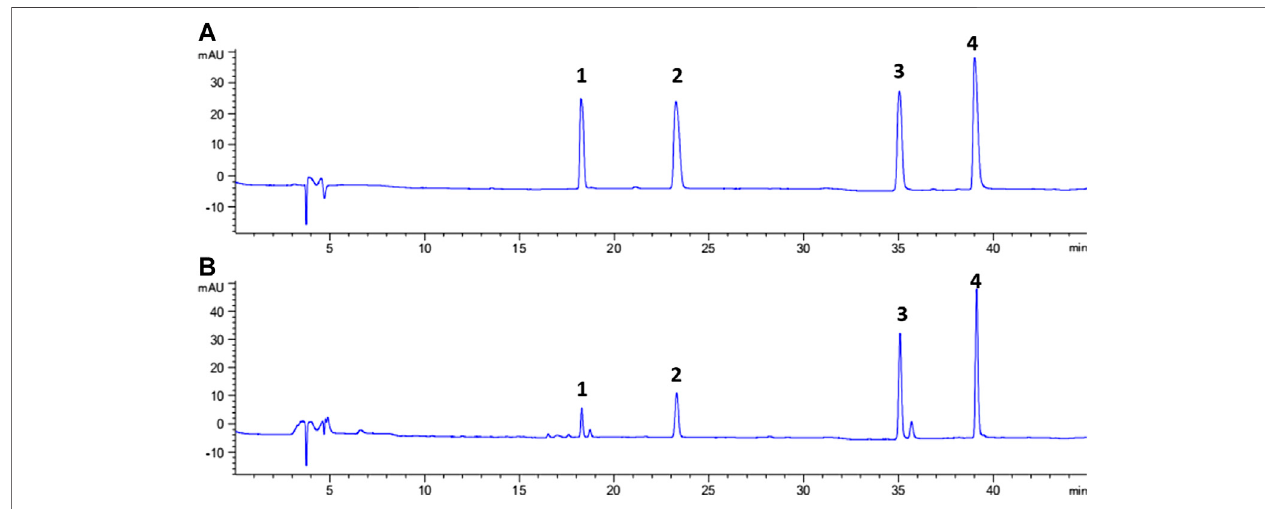
FIGURE3| Typical chromatograms ofstandardsolutionoffour analytes (A) and samplesolution (B) ,peak 1: daidzin; peak 2:genistin;peak 3: daidzein; and Peak 4: genistein.